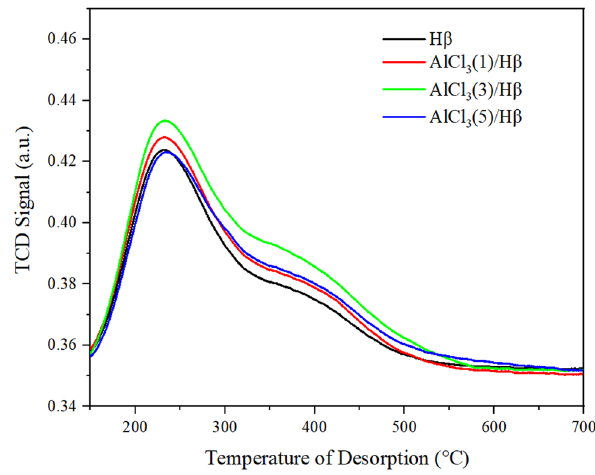
Figure 3: NH 3 - TPD spectra of AlCl 3 /H β catalysts prepared with dif - ferent concentrations of AlCl 3 .